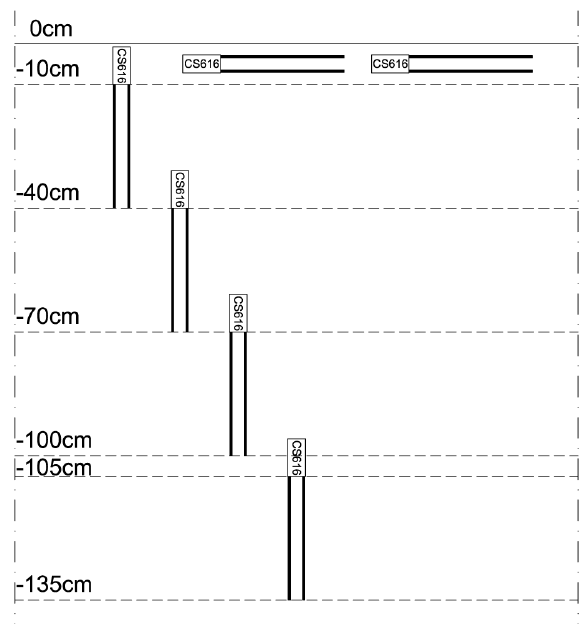
Fig. 2. Relative position of the six soil moisture probes installed at the station of Tondikiboro in